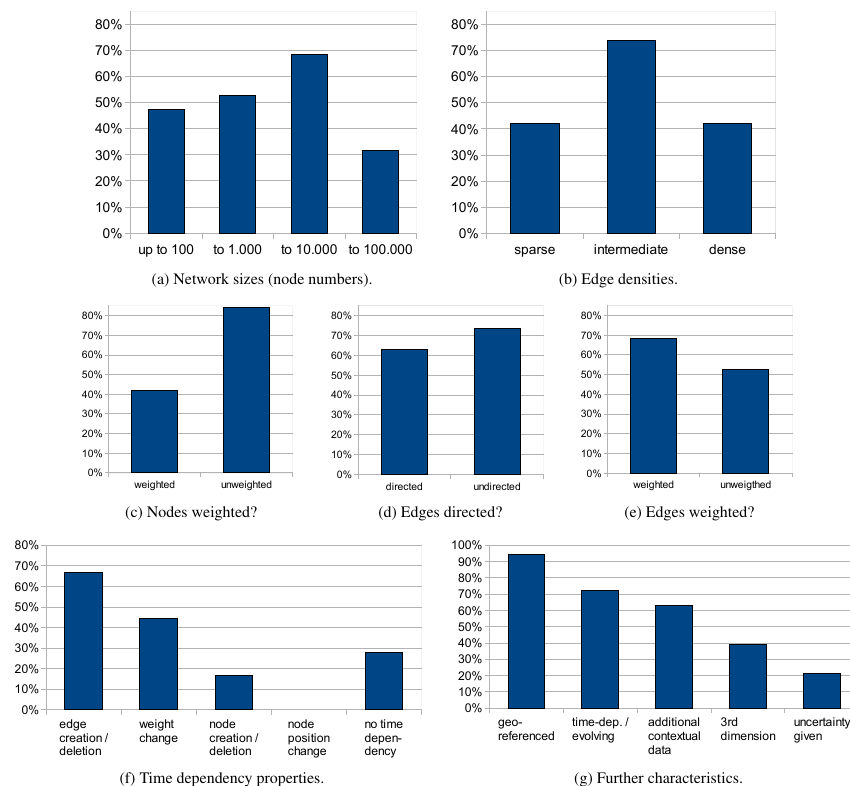
Figure 2. Network characteristics provided by interviewed network